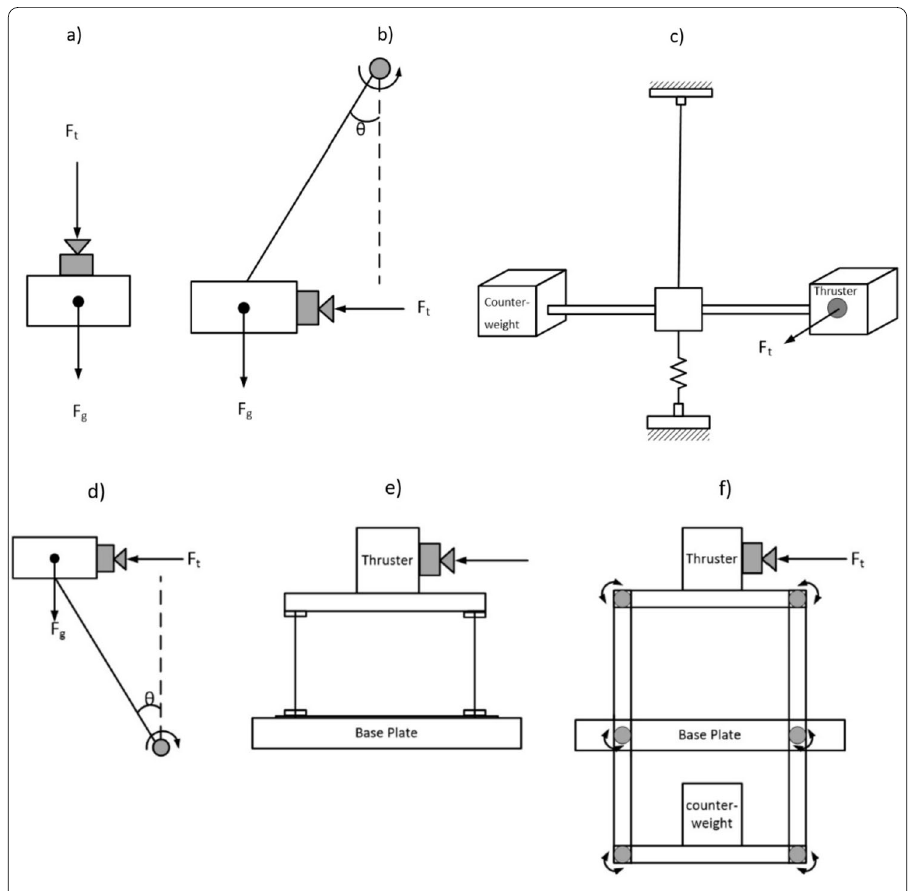
Figure 2 Some common design options for a thrust balance: ( a ) vertical weigh cell, ( b ) normal pendulum, ( c ) torsional pendulum, ( d ) inverted pendulum, ( e ) inverted double pendulum, ( f ) counterbalanced